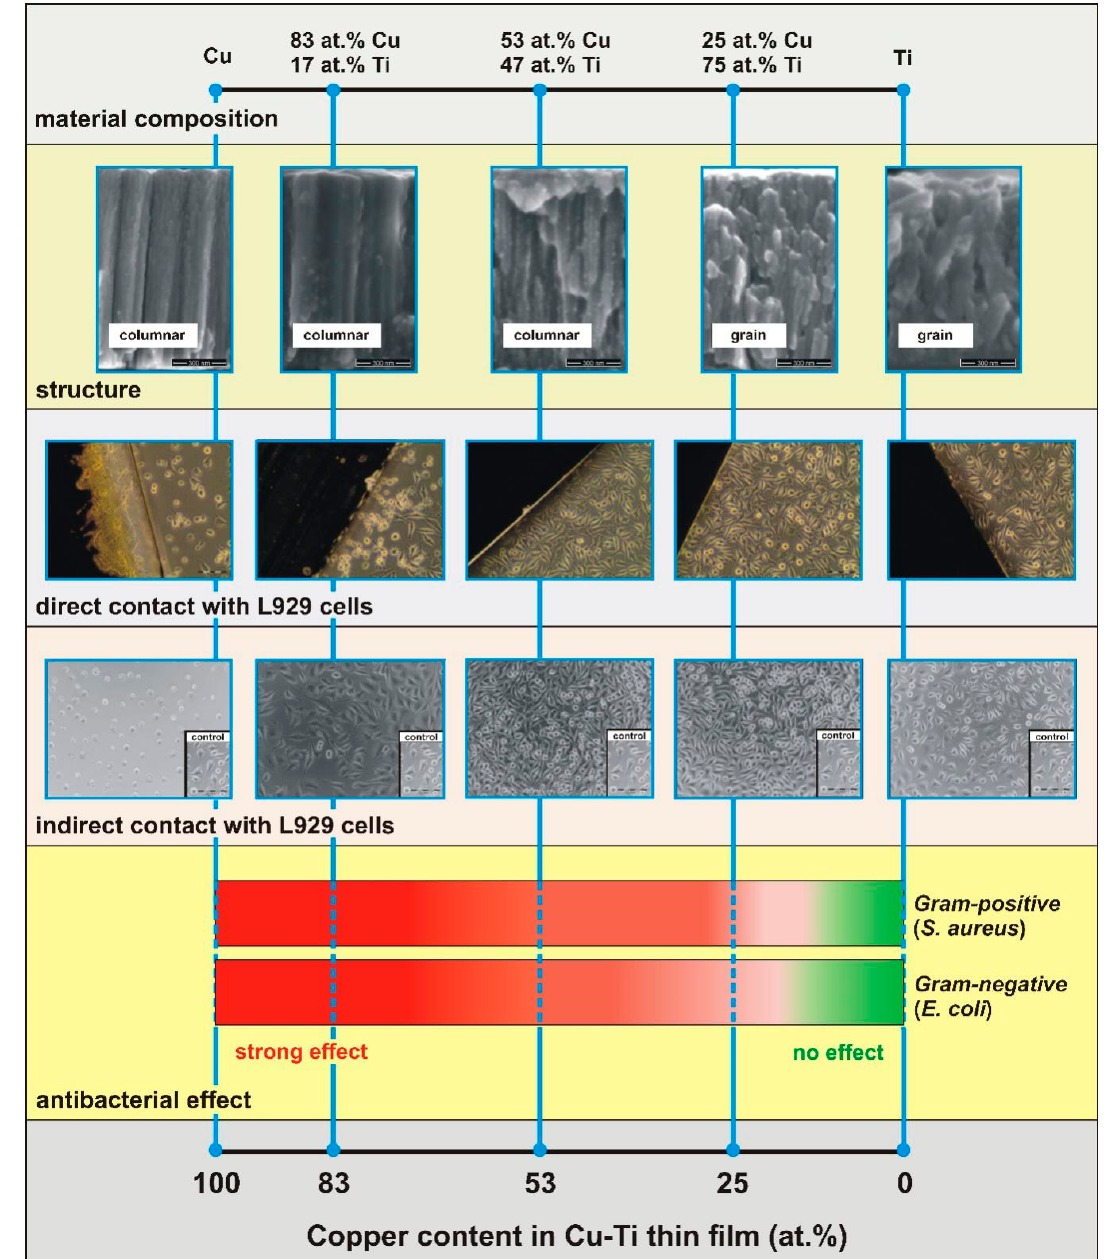
Figure 9. The influence of material composition on the biological properties of nanocrystalline thin films based on copper and